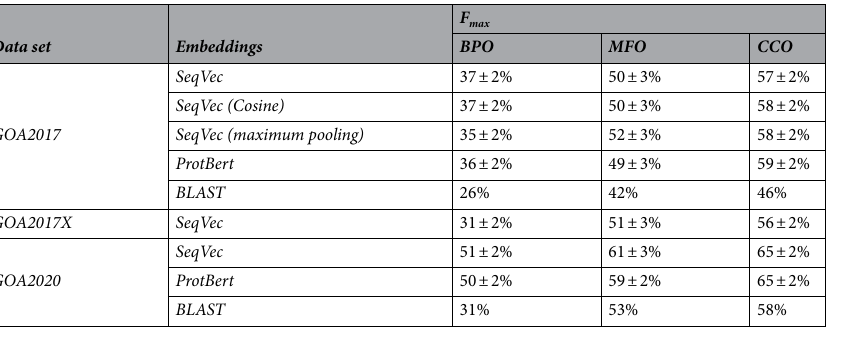
Table 1. Performance for CAFA3 targets for simple GO annotation transfers * . *Mean F max values for GO term predictions using embeddings from two different language models ( SeqVec or ProtBert ) or sequence similarity ( BLAST ) for the data sets GOA2017-100 (2017), GOA2017X (2017), and GOA2020-100 (2020) used for annotation transfer (note: the notation ‘-100 ′ implies that any entry in the data set with PIDE = 100% to any CAFA3 protein had been removed). By default, embedding distance was assessed by Euclidean distance (Eq. 4; exception marked cosine ), and per-residue embeddings were pooled by global average pooling (exception marked maximum pooling). All values were compiled for picking the single top hit (k = 1) and using the CAFA3 targets from the NK and full evaluation mode 19 . For all simple annotation transfers (embedding- and sequence-based), performance was higher for the more recent data sets ( GOA2020 vs. GOA2017 ). Error estimates are given as 95% confidence intervals. F max values were computed using the CAFA3 tool 18,19 .